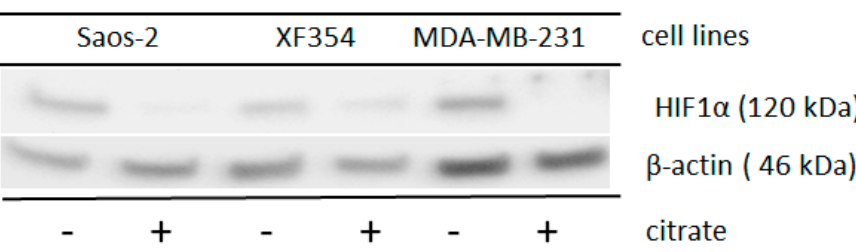
Figure 6. Impact of ascorbic acid on the normoxic and hypoxic HIF1 α level in MDA ‐ MB ‐ 231 cell. After the of application of HIF1 α‐ siRNA and/or the simultaneously application of 5 mM glutamine and/or 100 μ M ascorbic acid for 24 h under normoxic or hypoxic conditions, western blot analysis of HIF1 α and β‐ actin as a loading control was performed. Ascorbic acid significantly reduces the glutamine ‐ induced normoxic HIF1 α‐ level. Data from three independent experiments. (Please see Supplemental Figure S12 and the results from the densitometric evaluation of the Western blots). Carbonic anhydrase ( CAIX ) is a transcriptional target of the transcription factor HIF1 [16]. The results from the analysis of CA9 mRNA levels under normoxia confirms the data regarding HIF1 α